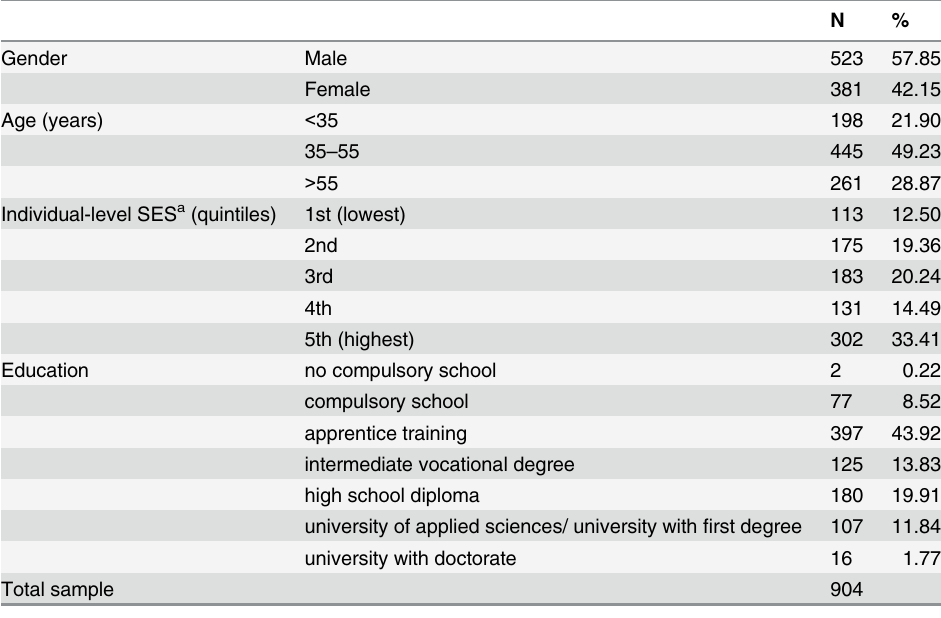
Note: Percentages do not always add up to 100% due to rounding errors.